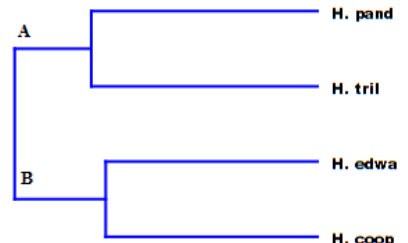
Figure 2. Principal component analysis (PCA) of the VOCs emitted from the investigated Helichrysum species.